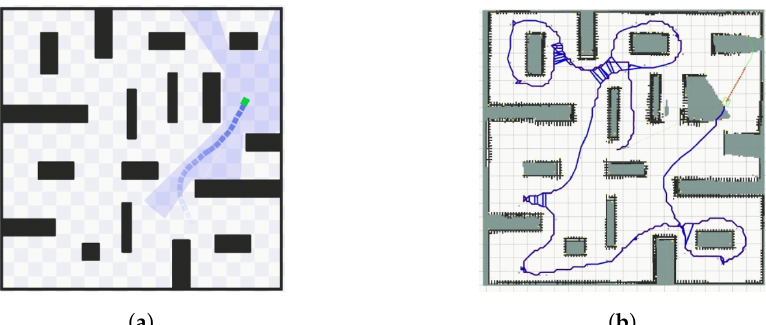
Figure 16. The test result of our autonomous exploration algorithm in Stage. ( a ) The Stage scene. In this scene, the black squares are obstacles, the green square is the robot’s position, the blue squares are the robot’s historical trajectories, and the light blue area is the radar coverage area. ( b ) The explored map. In this map, the black grids are obstacles, the white grids are the free areas, and the dark green grids are unknown areas. The blue curve is the robot’s historical trajectories and the blue line indicates that a closed loop has been detected. Red and green curves are the robot’s current